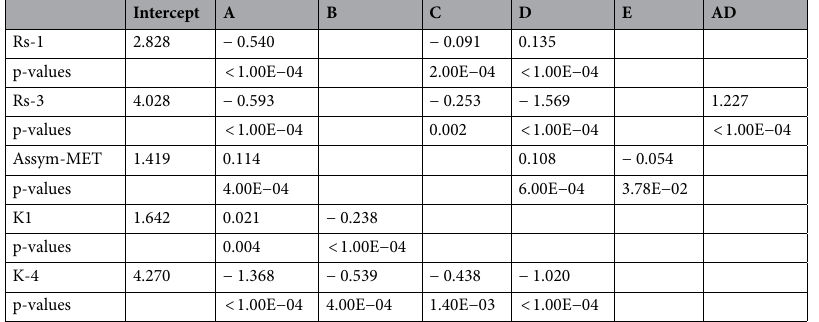
Table 1. Coefficients and ANOVA statistical analysis for the five studied factors of the screening design. Rs: resolution, Assym: asymmetry; K ′ : capacity factor; A: %MeOH; B: flow rate; c: buffer pH; buffer pH and E: buffer